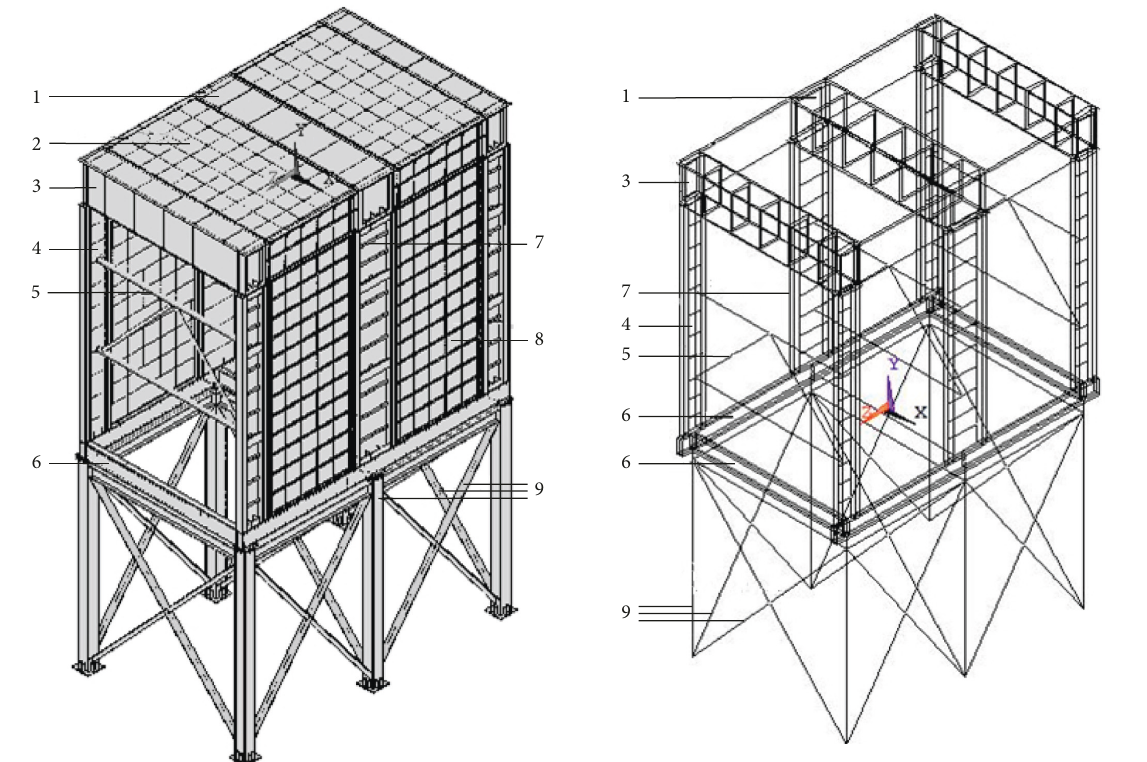
Figure 10: The solid model of main structure of the larger electrostatic precipitator. (1) Wide girder, (2) roof slab, (3) narrow girder, (4) narrow column, (5) column support, (6) bottom beam, (7) wide column, (8) side wall slab, (9) bracket.